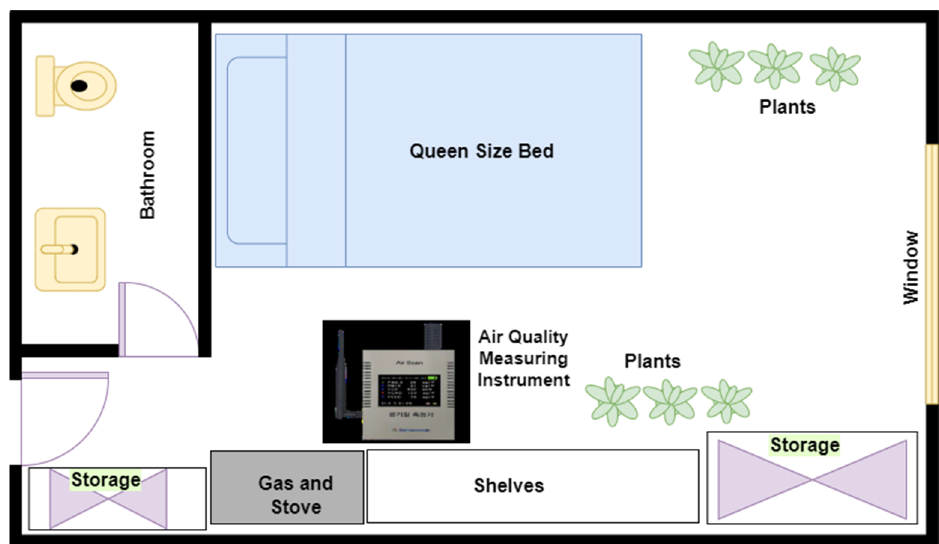
Figure 1. Diagram of the apartment showing the doors, windows, Kitchen shafts, indoor air pollutants (IAP) monitors, and the entry and exit path. Table 1. Detailed information about the apartments.